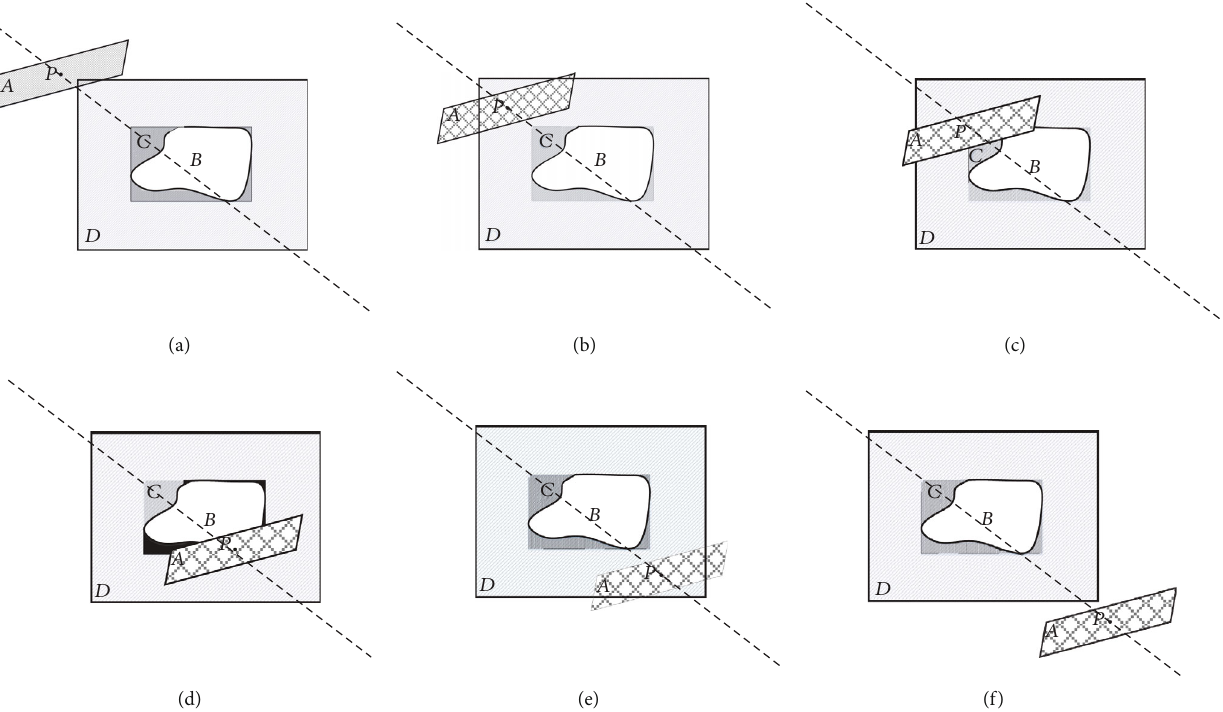
Figure 9: Schematic diagram of the algorithm principle. (a) Polygon D does not contain point P ; (b) polygon D contains point P , polygon B disjoints with polygon A ; (c) polygon B intersects with polygon A ; (d) polygon B intersects with polygon A ; (e) polygon D contains point P , polygon B disjoints with polygon A ; (f) polygon D does not contain point P .